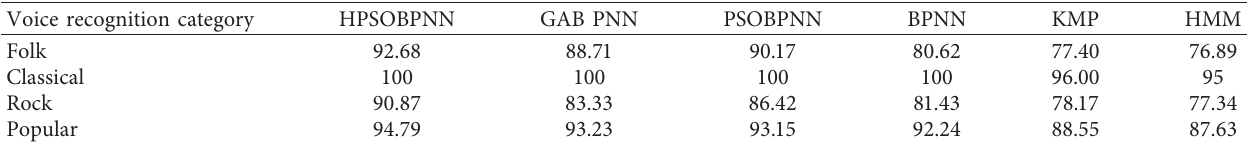
Figure 5: Comparison of different versions of the song in the space of beat duration-beat Table 1: The classification accuracy rate of various models (%).